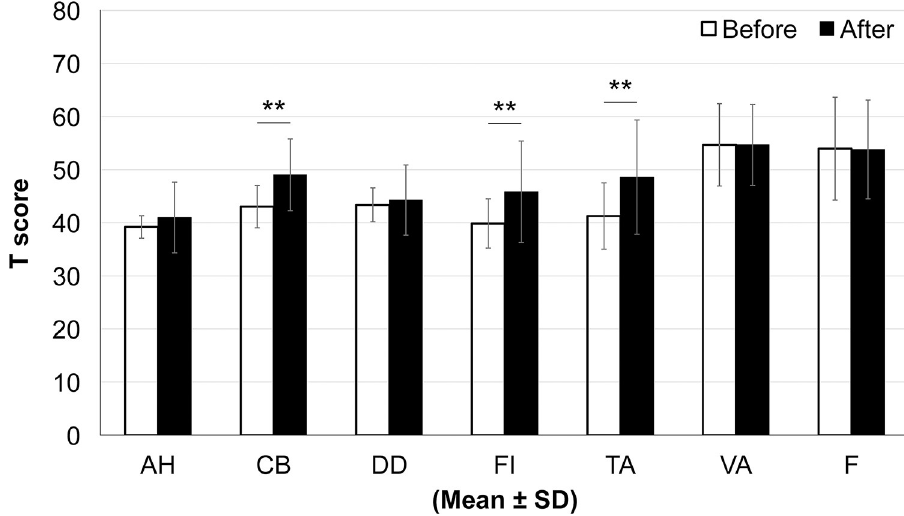
Fig 10. Subjective effects of the tension odor. The model tension odor, formulated according to the threshold, was continuously sniffed by participants for 2 min. POMS 2 measured the participants’ subjective status at baseline and immediately after sniffing the sample. Note: AH: anger–hostility, CB: confusion–bewilderment, DD: depression– dejection, FI: fatigue–inertia, TA: tension–anxiety, VA: vigor–activity, and F: friendliness. The negative scores of “tension–anxiety” (p < 0.01), “confusion–bewilderment” (p < 0.01), and “fatigue–inertia” (p < 0.01) significantly increased after sniffing the model tension odor (Wilcoxon’s signed-rank test).